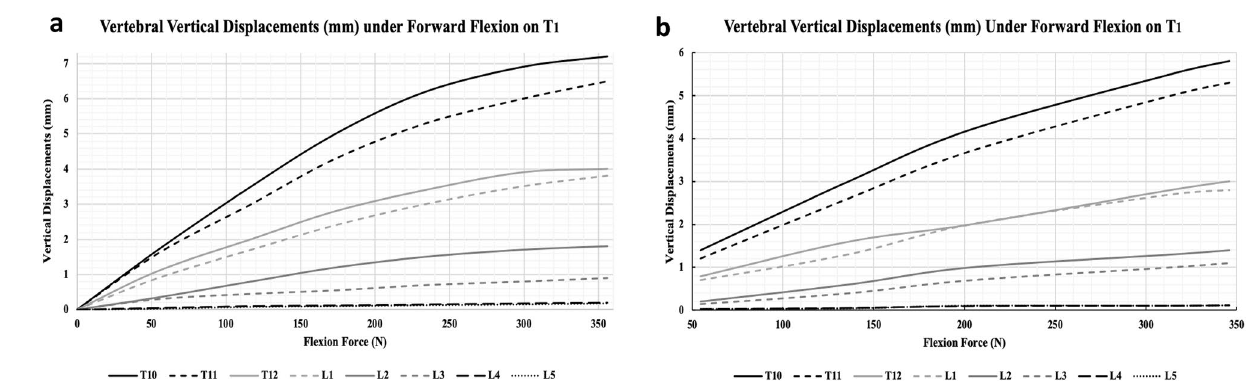
Figure 6. Full spine validation. ( a ) Recorded vertical vertebral displacements in response to an external flexion force applied on the first thoracic vertebrae. ( b ) Verification of the external applied flexion force approach via a muscles active contraction approach, whereby involved muscles actively contract to mimic the external flexion